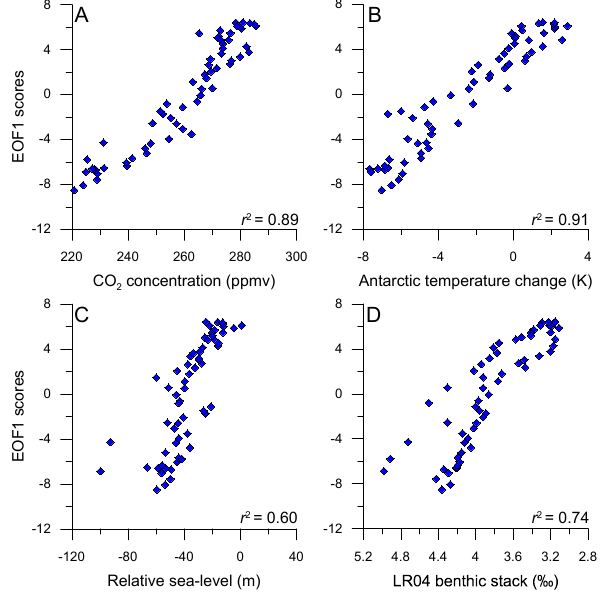
Fig. 9. Cross plots showing the correlation between EOF1 scores and (A) atmospheric CO 2 concentration (Siegenthaler et al., 2005), (B) Antarctic temperature change (Jouzel et al., 2007), (C) Red Sea relative sea level change (Rohling et al., 2009) and (D) the benthic LR04 stack (Lisiecki and Raymo, 2005). EDC ages of the Antarc- tic temperature record were converted into LR04 ages according to Parrenin et al. (2007).